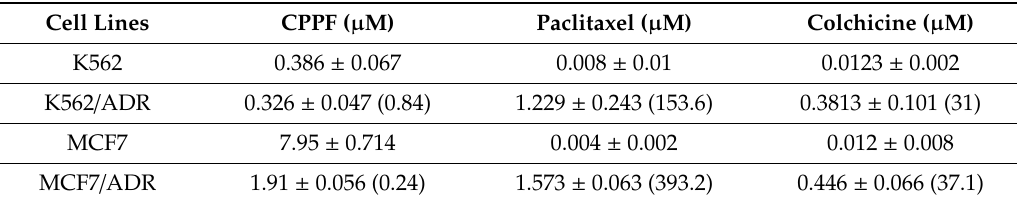
Table 1. IC 50 of multidrug-resistant cell